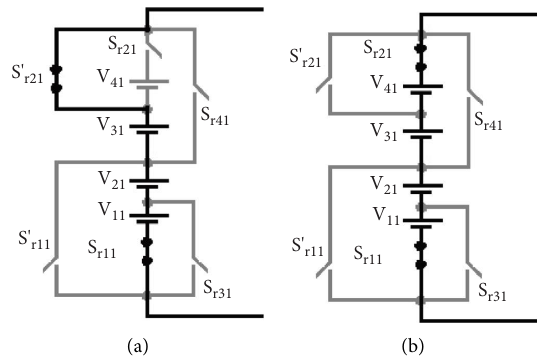
Figure 5: Operating mode: (a) V 11 + V 21 + V 31 and (b) V 11 + V 21 + V 31 + V 41 .